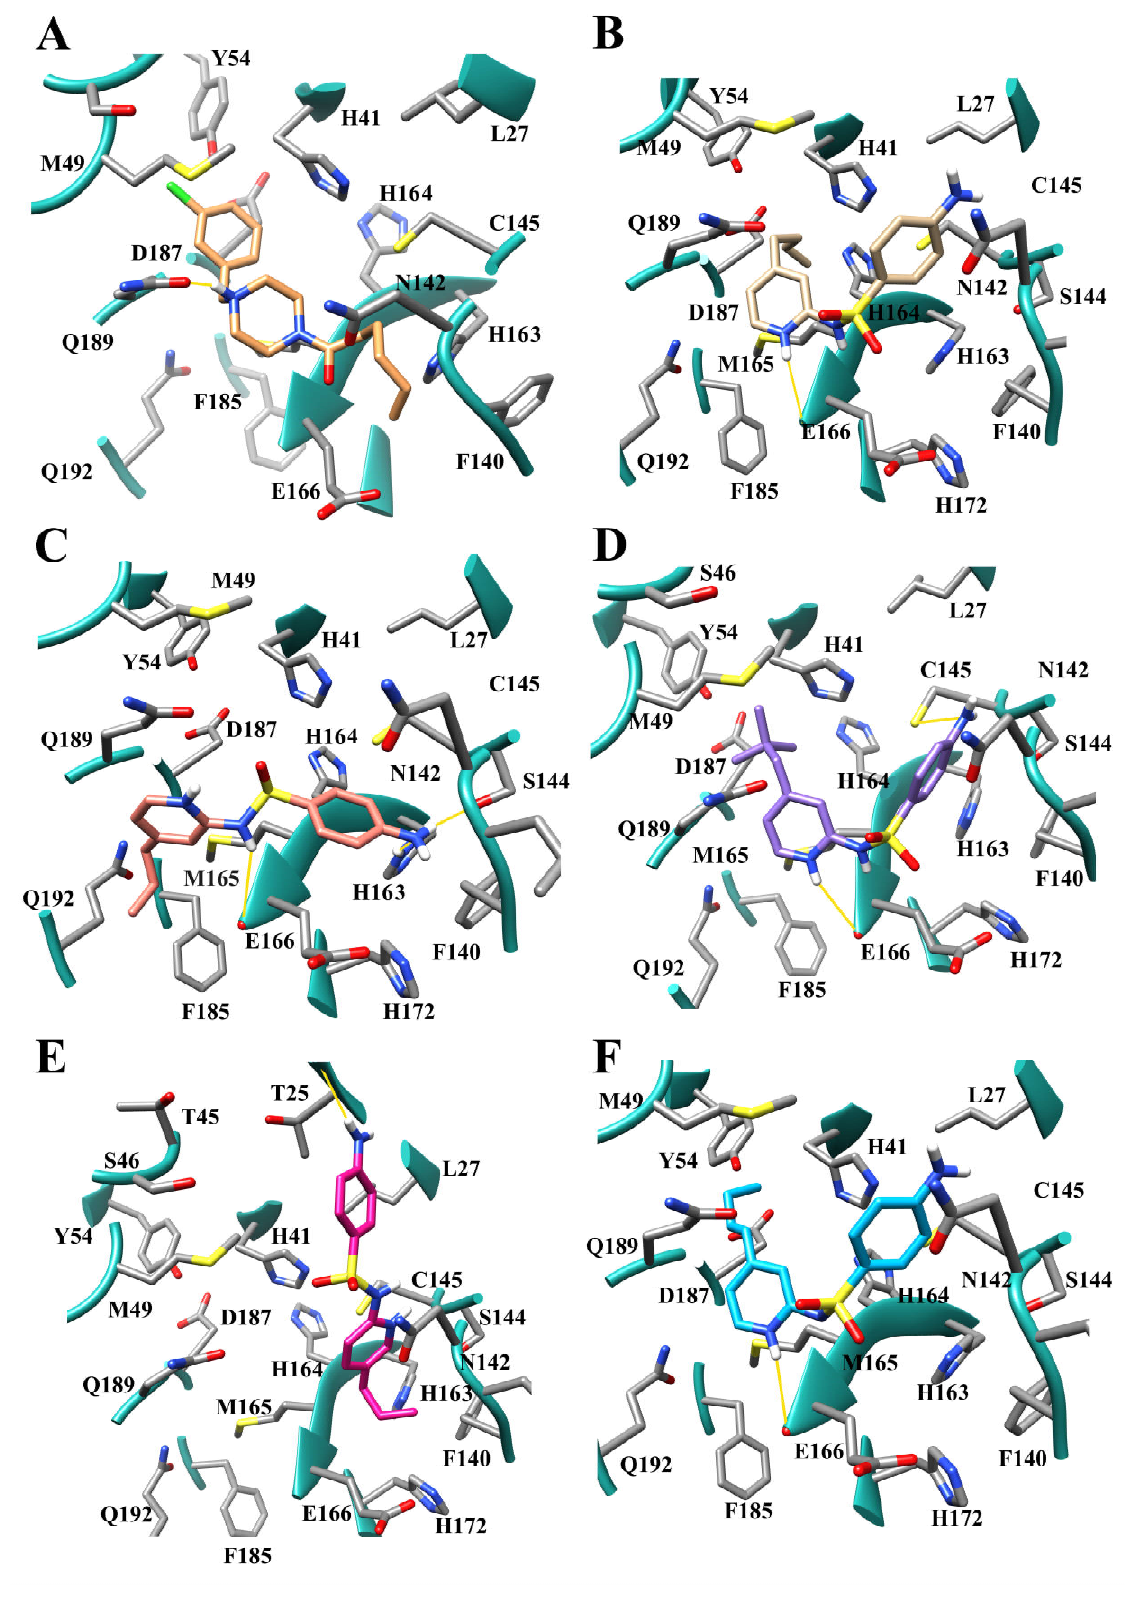
Figure 7. Modes of binding for ( A ) HS04 (sandy); ( B ) SD11 (tan); ( C ) SD12 (salmon); ( D ) SD15 (plum); ( E ) SD23 (deep pink); ( F ) and SD27 (blue) compounds designed for aliphatic substituent dataset in PDB 6LU7. Hydrogen bonding is indicated by solid yellow